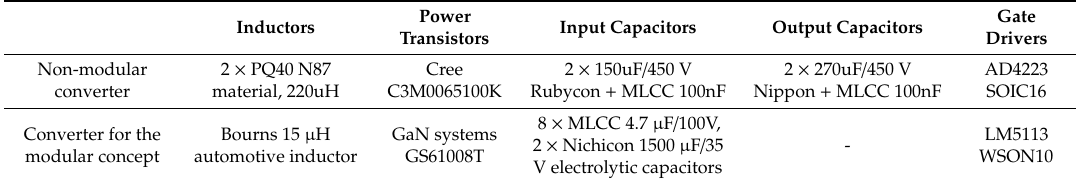
Table 5. List of used electronic parts for modular and non-modular concept.